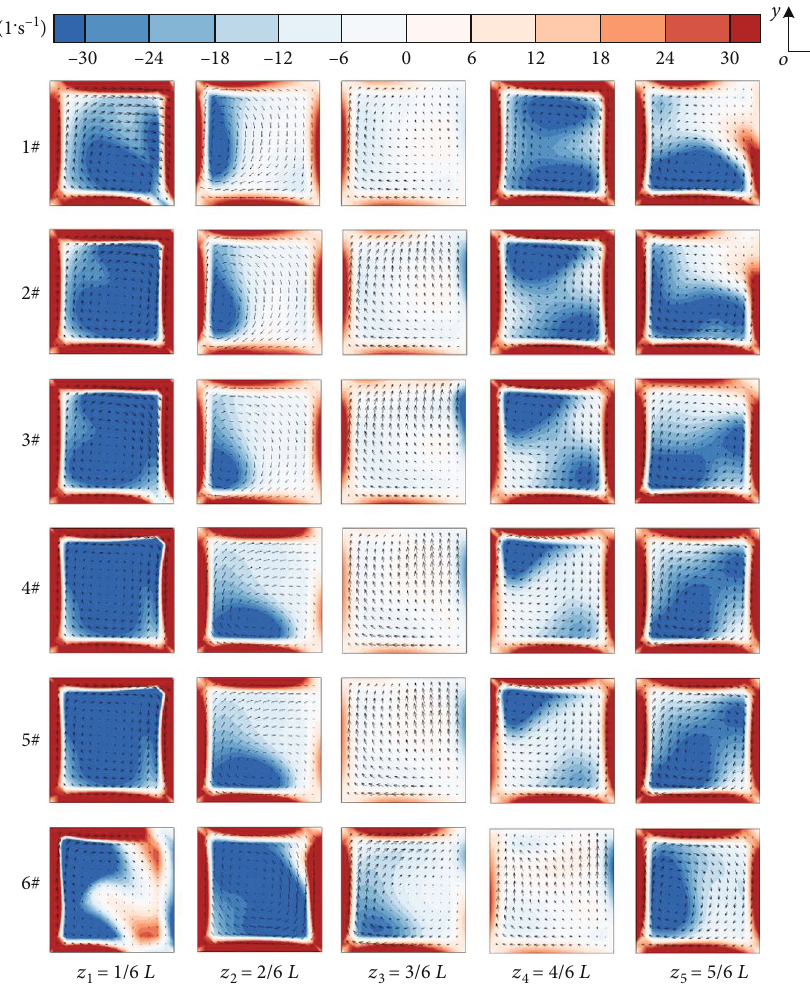
Figure 8: Instantaneous vorticity contours and associated velocity vectors in